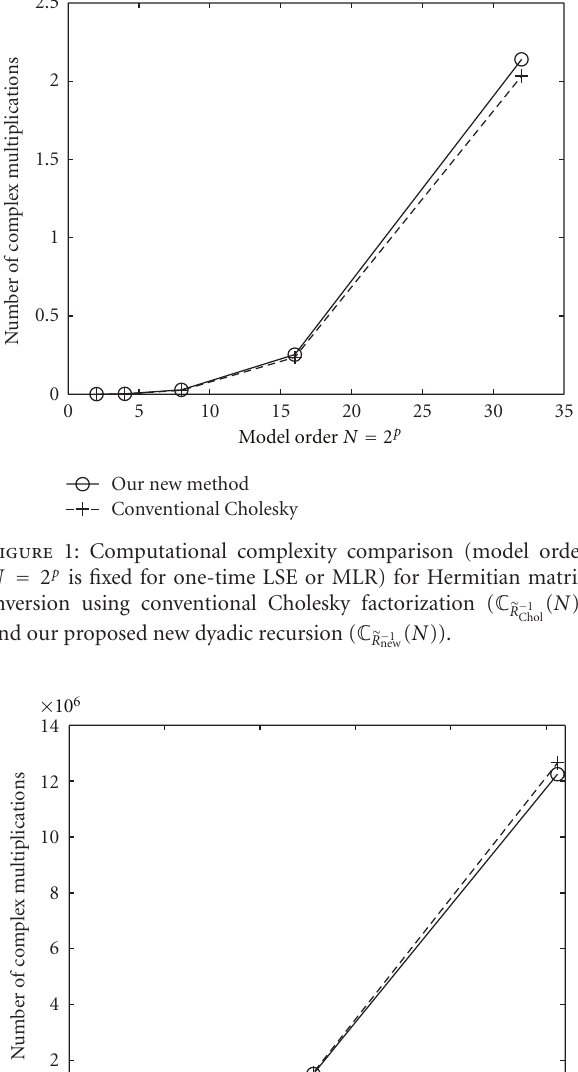
Figure 2: Computational complexity comparison (accumulated complexity for the sequential rank-adaptive LSE or MLR with ter- minal model order N = 2 m ) for Hermitian matrix inversion using ( N )) and our pro- conventional Cholesky factorization ( C (cid:2) R − 1 Chol,seq posed new dyadic recursion ( C (cid:2) R − 1 ( N new,seq